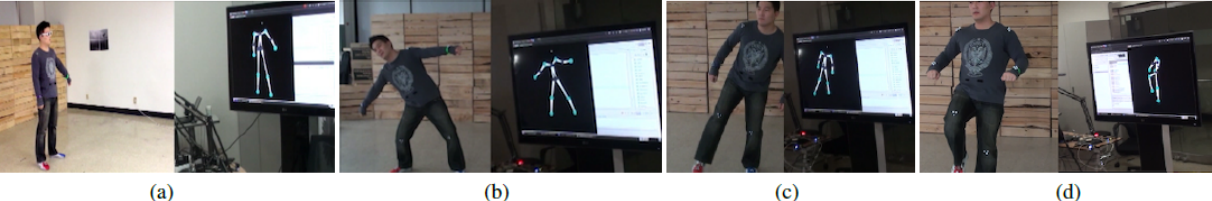
Figure 12. A real-time demonstration of the Samba motion capture system. ( a ) Arm lifting. ( b ) Surfing. ( c ) Fake motion. ( d ) Knee